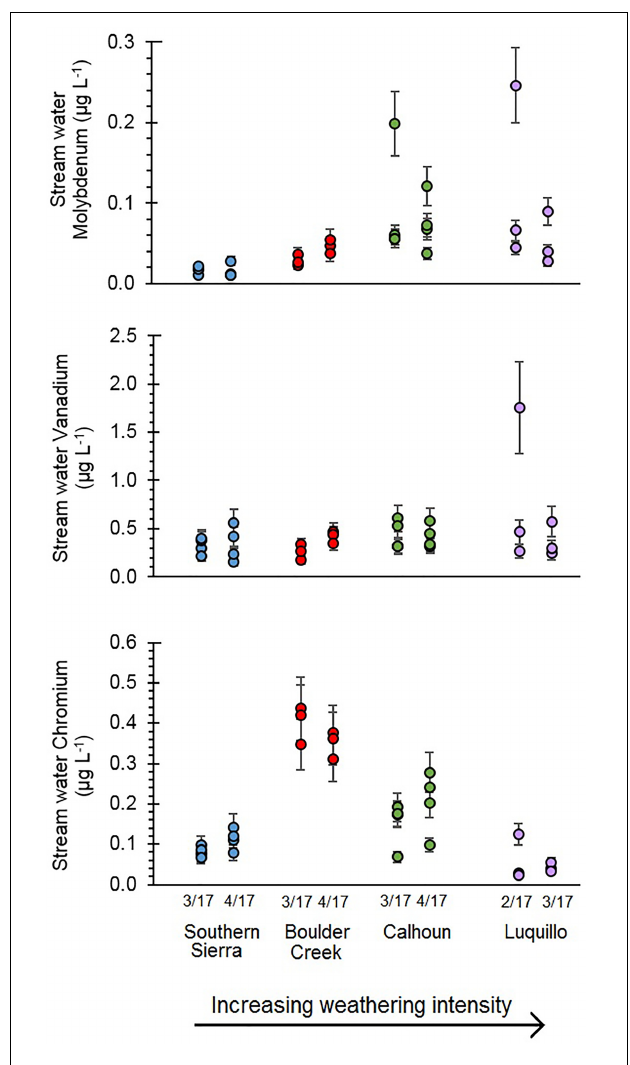
FIGURE 6 | Stream water oxyanions (Mo, V, and Cr) concentrations in solution. Samples were filtered to < 0.45 µ m. Error bars are coefficients of variation for each measurement.